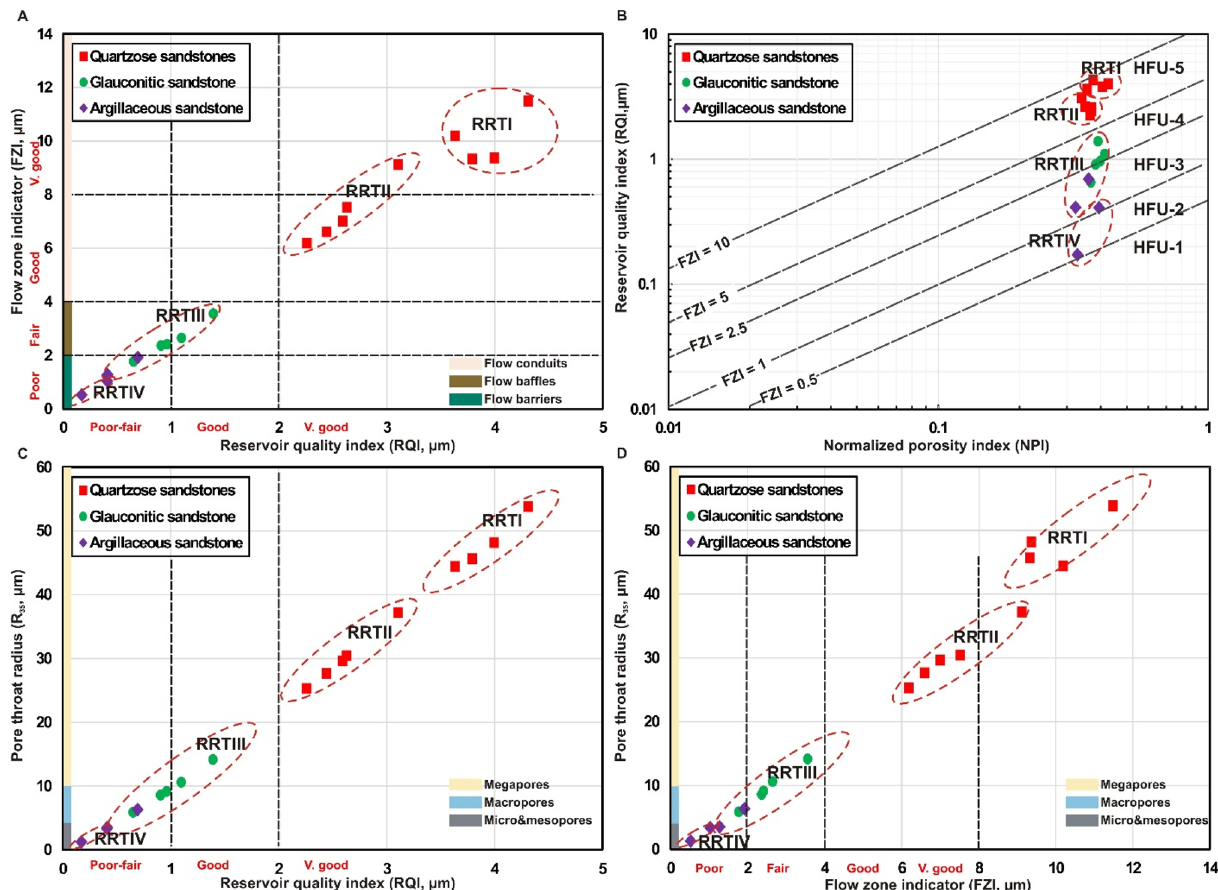
Fig. 12 a Reservoir rock typing (RRT) classification of the Abu Madi sandstones based on their reservoir quality and flow characteristics, b log–log plot of normalized porosity index (NPI) versus reser- voir quality index (RQI) illustrates the different hydraulic flow units (HFUs) encountered in the studied sandstone intervals, c reservoir